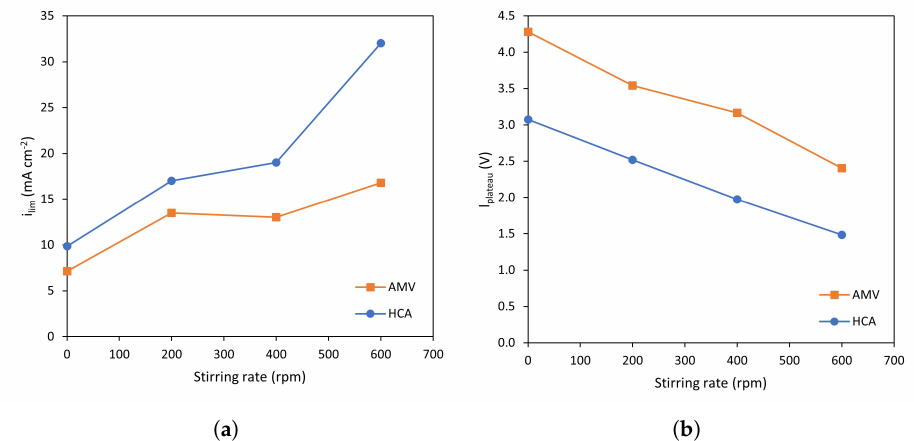
Figure 4. Comparison between the characteristic parameters at various stirring rates for both mem- branes: ( a ) Limiting current density, and ( b ) plateau length.